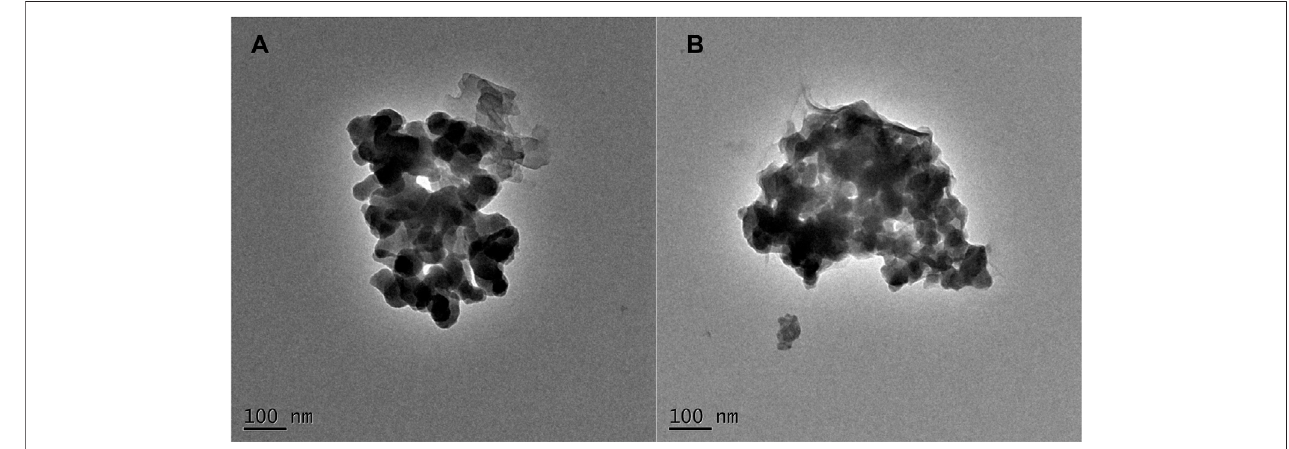
FIGURE 4 | TEM image of UIO-66 (A) and UIO-66-SO 3 H (B) .